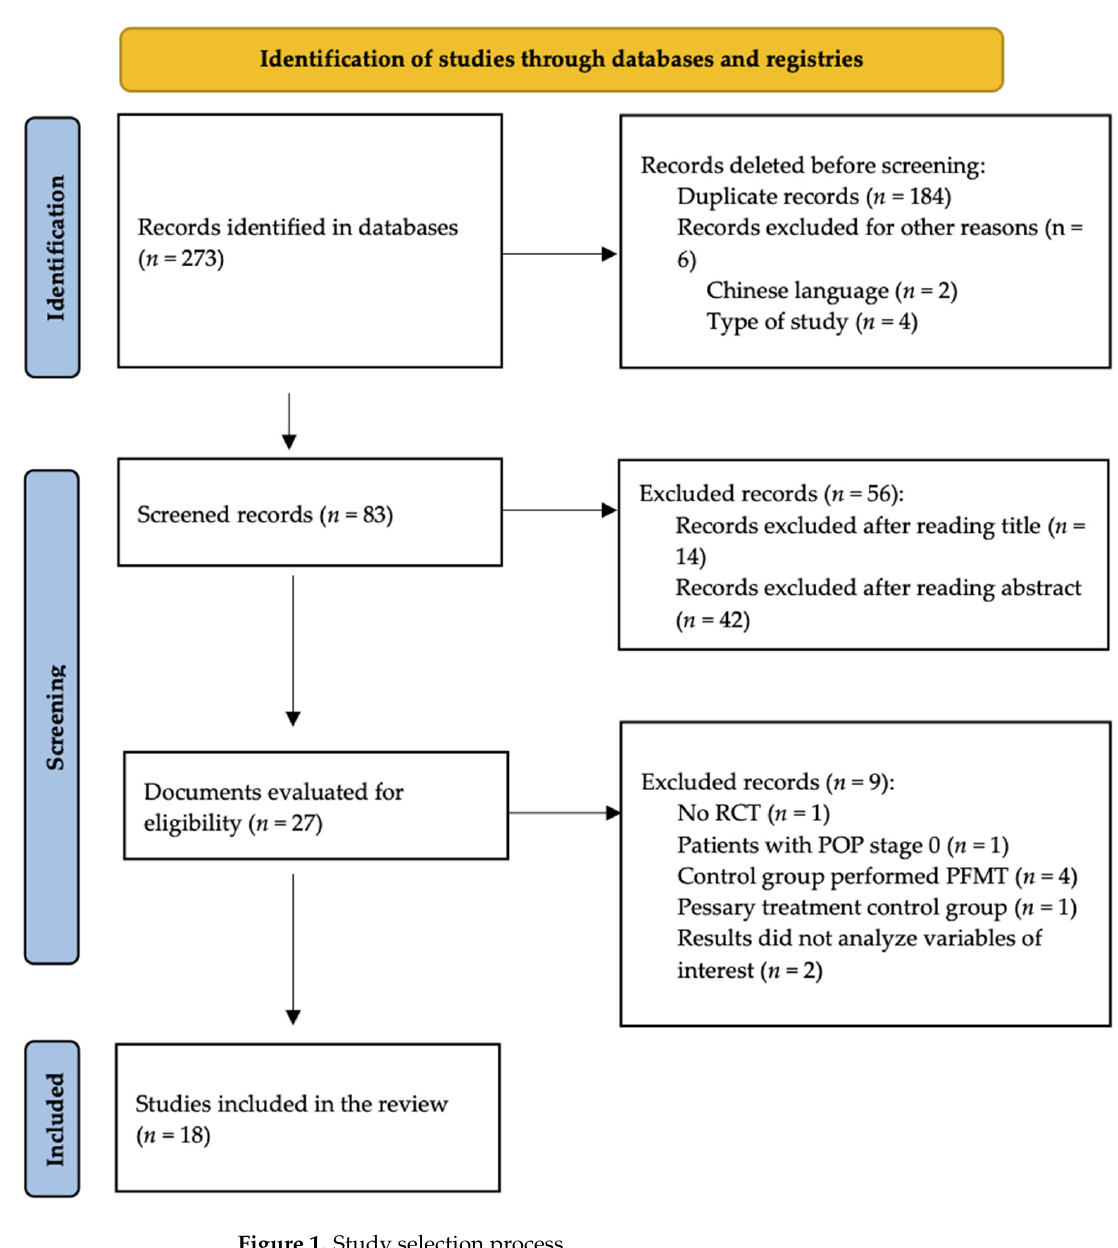
Figure 1. Study selection process.